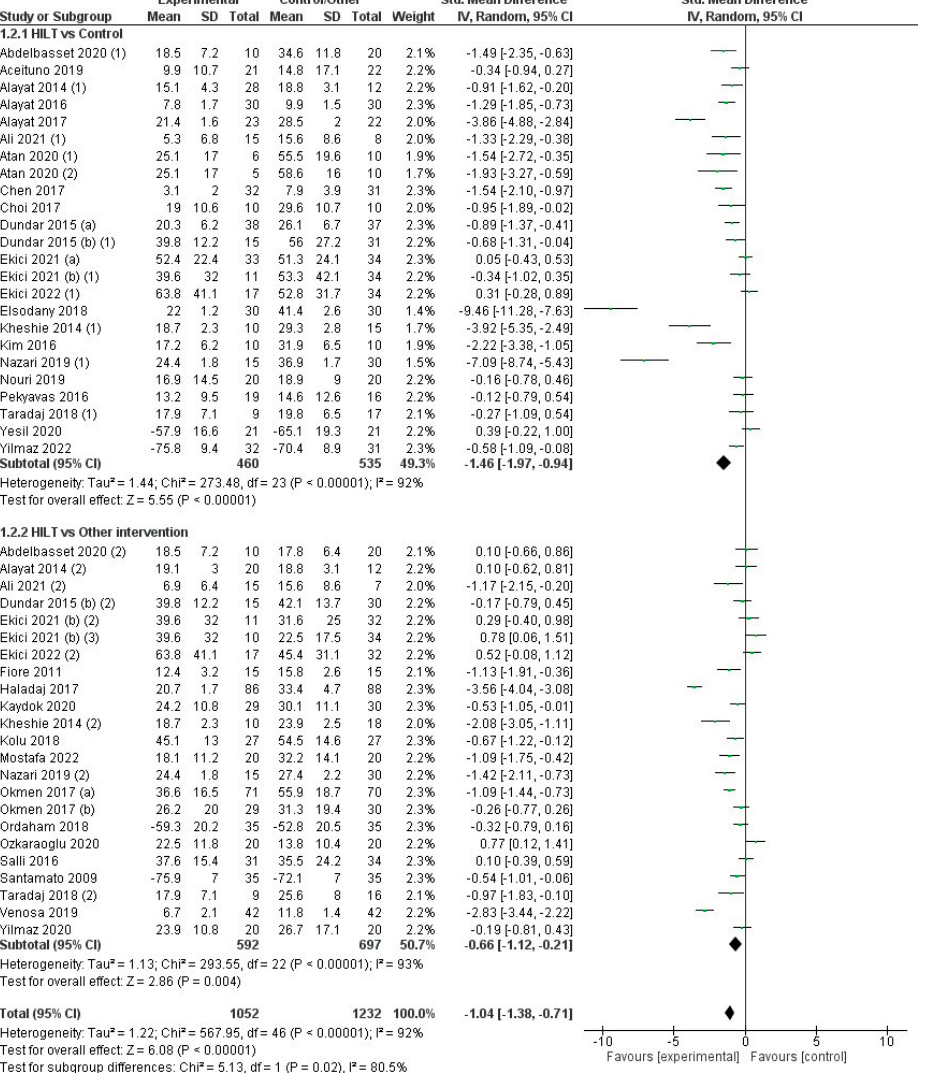
Figure 5. Forest plot for the overall effect on functionality comparing high-intensity laser therapy (HILT) vs. control/another intervention and subgroup analysis depending on the comparator (HILT vs. control/HILT vs. another therapy). For studies with three arms: (1) Comparator: control or sham control. (2) Comparator: another